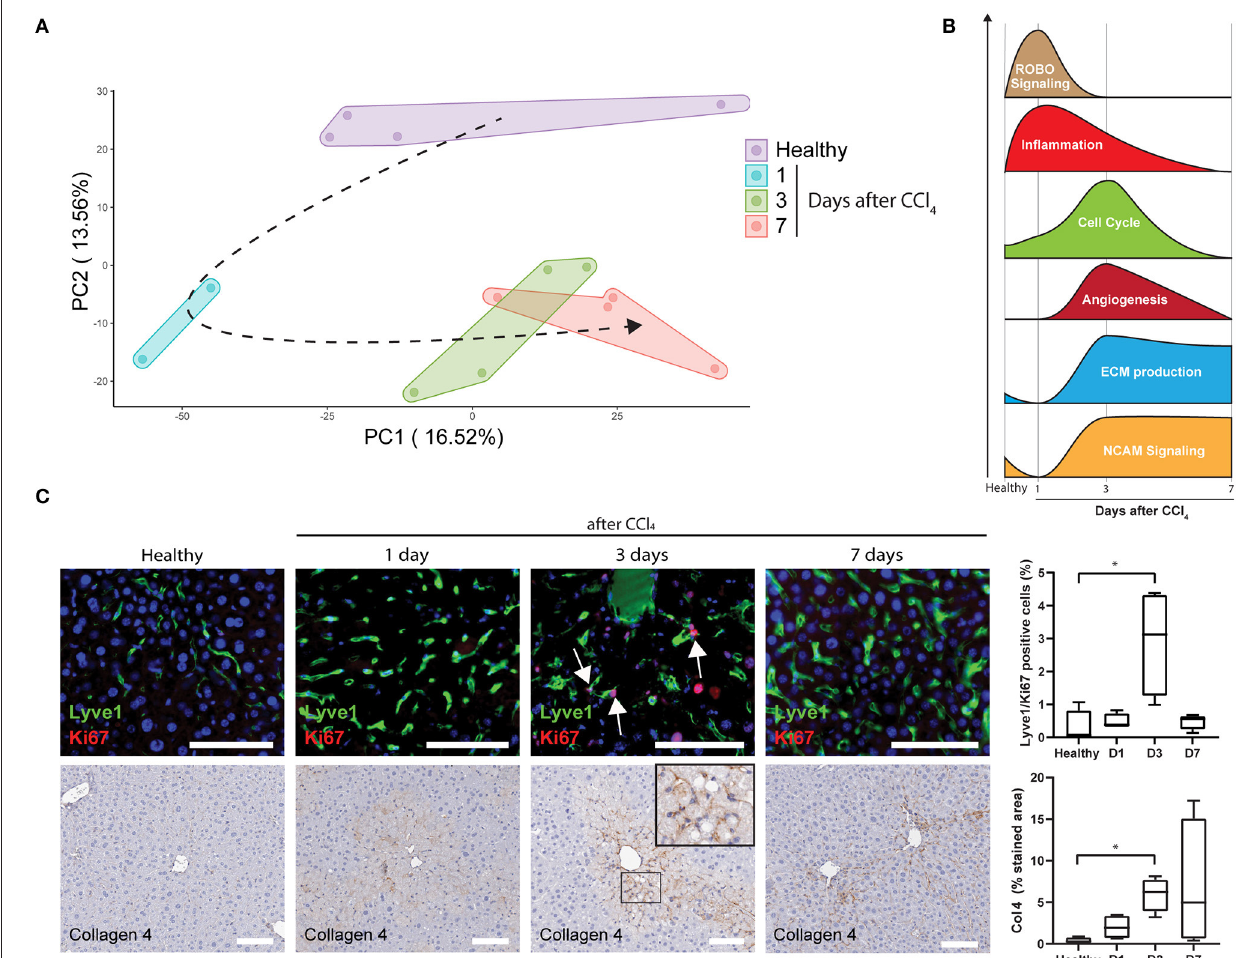
FIGURE 4 | Upregulated pathways in LSECs during acute liver injury (A) PCA of LSECs from healthy livers and livers after an acute injury by CCl 4 administration. (B) Schematic representation of pathway analysis from LSECs isolated after CCl 4 administration. (C) Immunofluorescence staining of Lyve1/Ki67, immunohistochemistry staining and quantification of Collagen 4 (* P ≤ 0.05) and Lyve1/Ki67 positive cells (* P ≤ 0.05) on healthy livers and livers after CCl 4 administration (bar = 100 µ